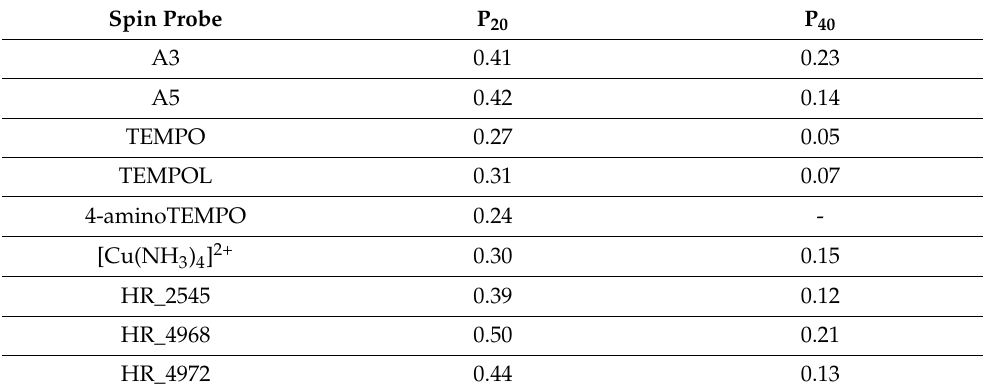
Table 2. Orientational order parameters of various probing molecules in the same GOM. Spin